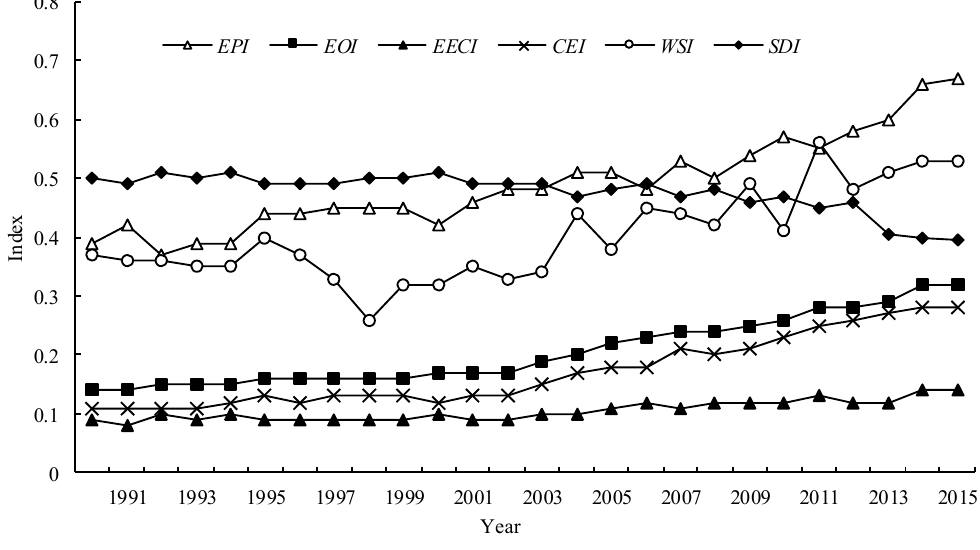
Figure 8. Dynamic changes of the sustainable development index.